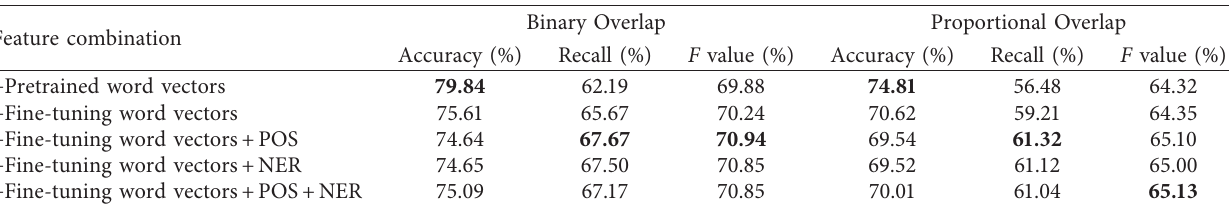
Table 4: Measurement of DSE recognition model under different feature